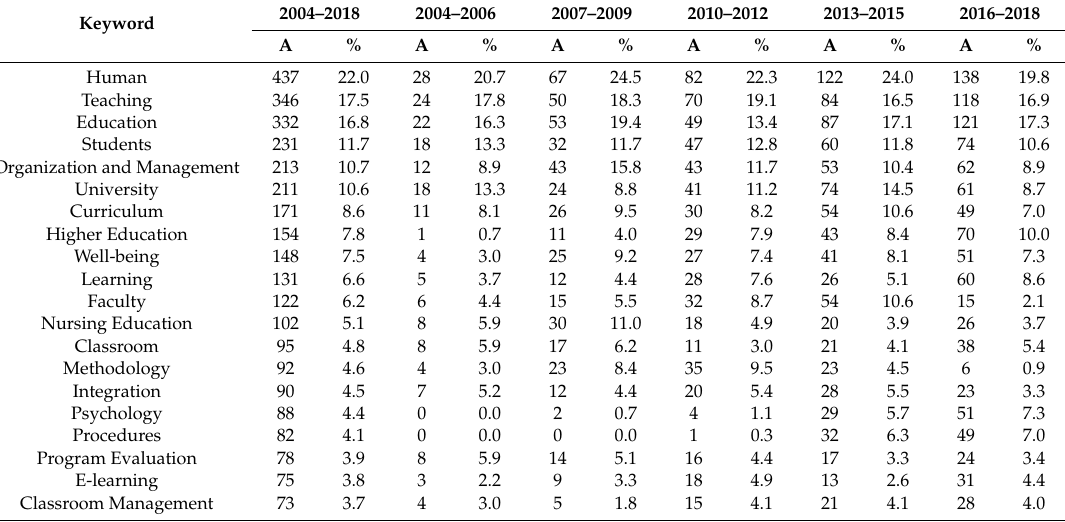
Table 9. Main keywords on the impact of the university classroom on managing the socio-educational well-being